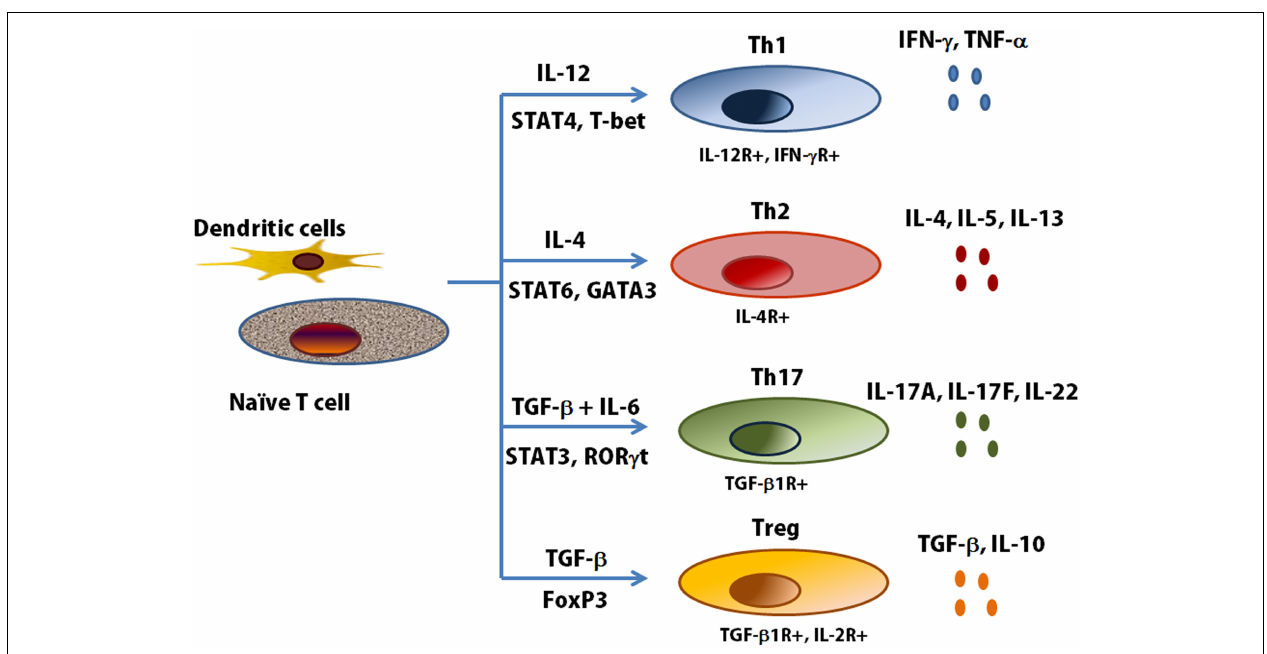
FIGURE 3 |T helper cell subsets and cytokine profiles .Th1,Th2 andTh17 cells are a separate lineage of CD4+T cells, distinct from otherT cell subsets. Every specificT helper cells produce its specific cytokines (Lazarevic and Glimcher, 2011).T-bet,T-box expressed inT cells; FoxP3, forkhead box P3; ROR, retinoid-related orphan